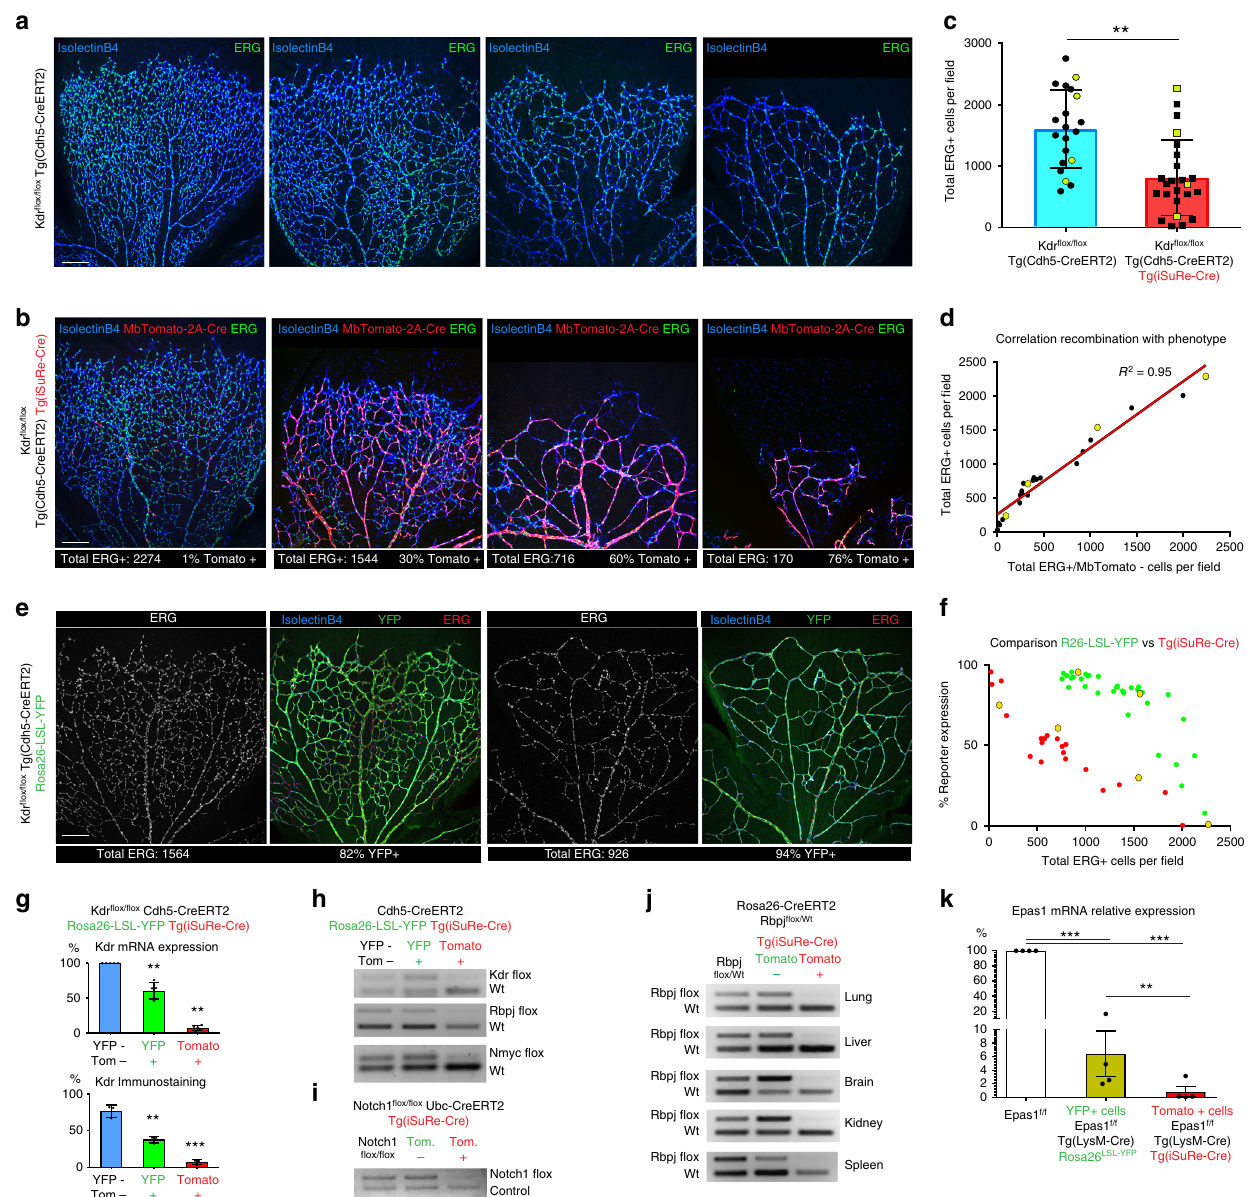
Fig. 4 The Tg(iSuRe-Cre) allele increases the ef fi ciency of inducible genetic modi fi cations. a – c Representative confocal micrographs of P6 retina vessels labelled with IsolectinB4 (endothelial surface) and anti-ERG antibody (endothelial nuclei), obtained from animals with the genotype indicated to the left and induced with high-dose tamoxifen from P1 to P3. Images represent the observed phenotypic variability; EC number for each image is depicted in chart c (yellow dots). 20 vs 24 retina microscopic fi elds were analysed ( n = 5 vs n = 6 animals per group). d Linear regression showing the high correlation (r 2 ) between total Erg + EC number (phenotype) and the number of Erg + /MbTomato- cells. e , f Representative confocal micrographs of P6 retina vessels from animals with the genotype indicated to the left and induced with high-dose tamoxifen from P1 to P3. Images represent the phenotypic variability of animals with the same genotype. EC number and reporter expression frequency is indicated below the fi gures. A comparison of EC number and reporter expression frequency is depicted in chart for 24 vs 34 retina microscopic fi elds ( n = 6 animals per group). Yellow dots in chart f represent the values for images in b and e. g qRT-PCR analysis of Kdr mRNA levels from FACS-sorted liver ECs ( n = 5 animals), or immunostaining analysis of liver sections of animals ( n = 3) with the indicated genotype (see also Supplementary Fig. 2b). h Semi-quantitative competitive PCR showing the ef fi ciency of Kdr, Rbpj and Nmyc deletion in FACS-sorted cells of adult mice with the indicated genotypes and induced with tamoxifen. Note that some cross-contamination of samples and DNA may occur during tissue dissociation and FACS of mutant and wild-type cells. i Semi-quantitative competitive PCR for the Notch1 fl oxed allele and a control genomic sequence showing the ef fi ciency of the Ubc-CreERT2 induced Notch1 deletion in Tomato + and Tomato- cells of the liver. j Semi-quantitative competitive PCR showing the ef fi ciency of Rbpj gene inducible deletion in the Tomato − and Tomato + cells of several distinct organs from Rosa26-CreERT2 mice induced with tamoxifen. k Epas1 mRNA relative levels (qRT-PCR) in LysM- Cre-reporter-expressing bone marrow-derived macrophages ( n = 4). Scale Bars 200 μ m. Error bars indicate StDev; ** p < 0.001; *** p < 0.0001. Two-tailed unpaired t -test (4c) or ANOVA (4 g and 4k). Source data are provided as a Source Data fi le